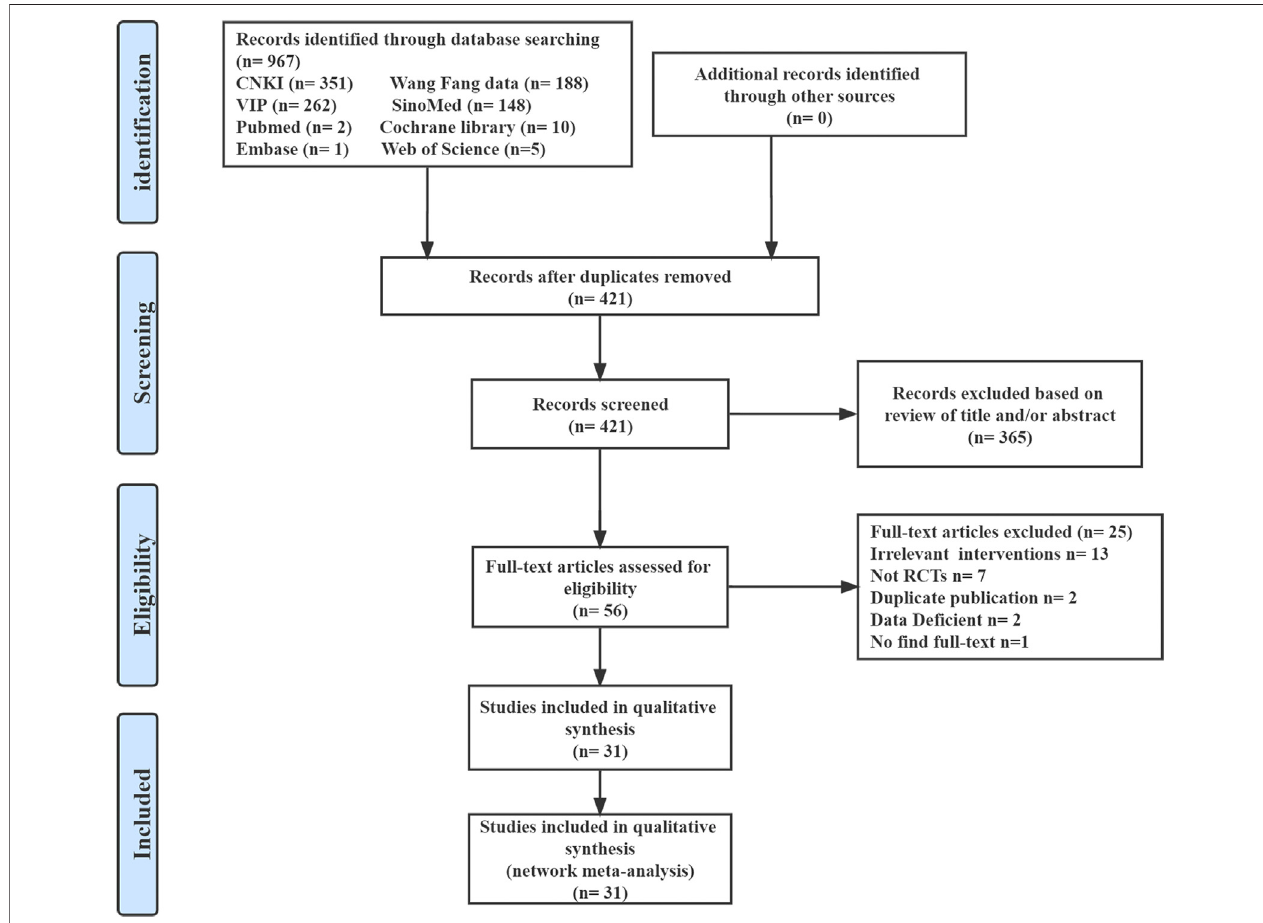
FIGURE 1 | Summary of evidence search and